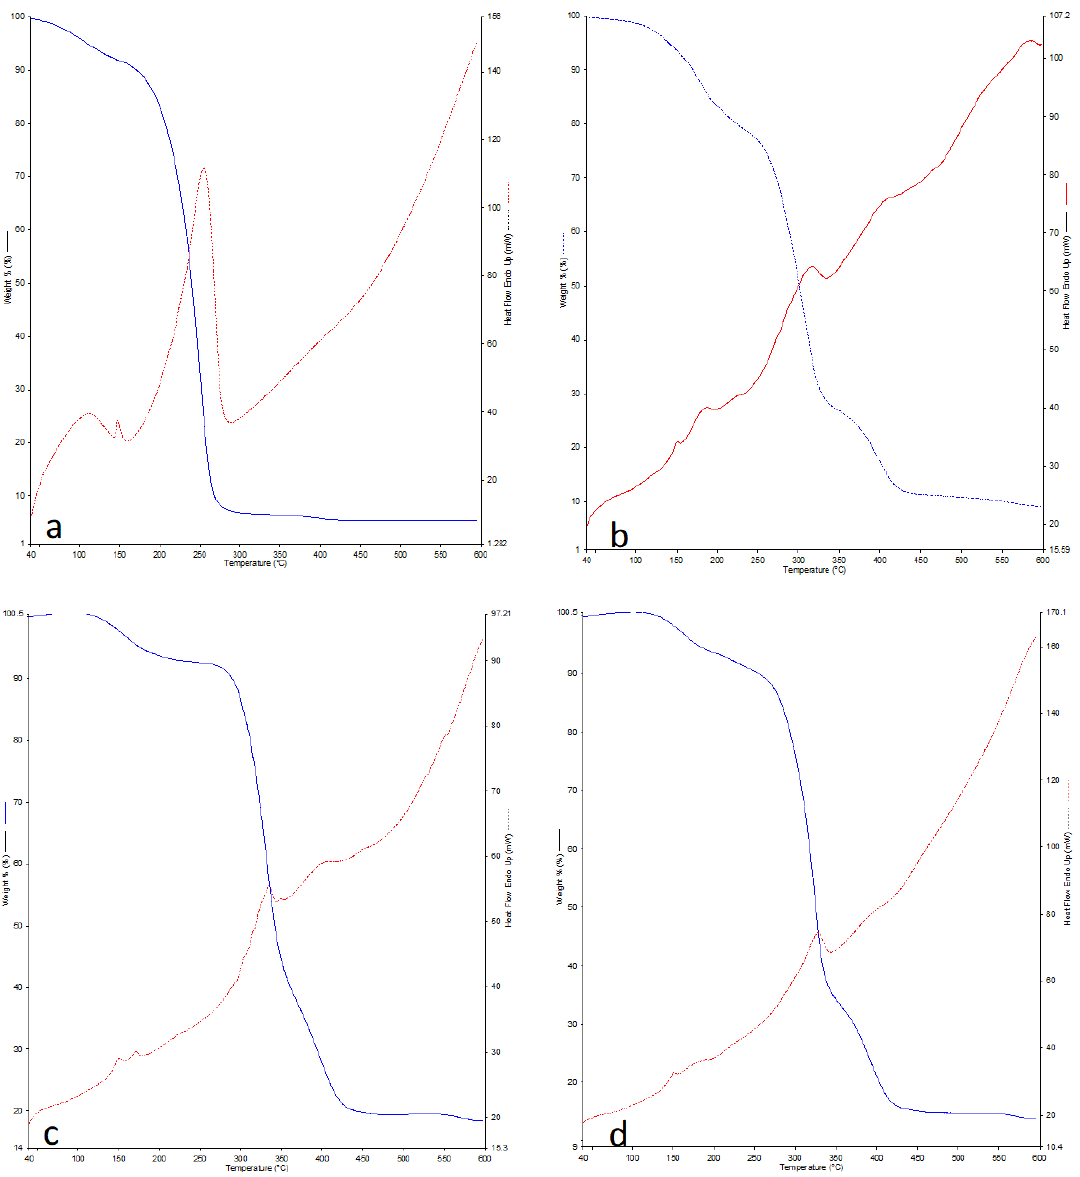
Figure 4. Thermal analysis of PLA films incorporated with different concentrations of anise essential oil (AE): neat PLA ( a ); PLA/0.5AE ( b ); PLA/1AE ( c ); PLA/1.5AE ( d ).